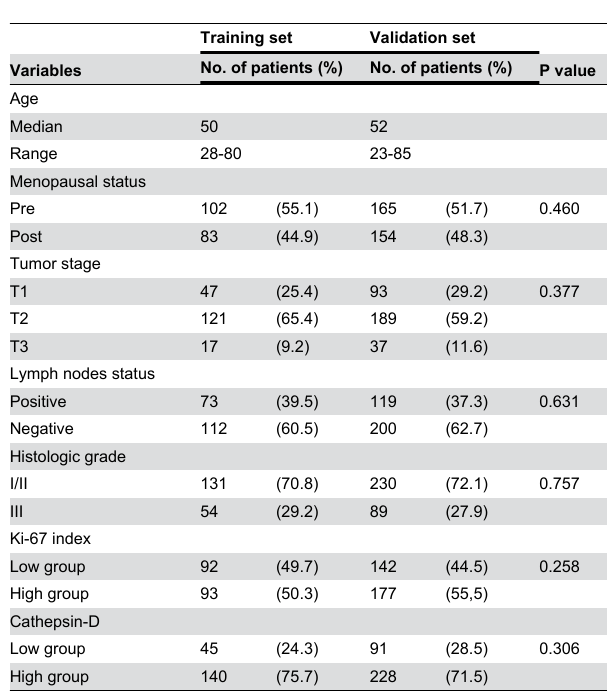
Table 1. Clinicopathological characteristics of patients in the training and validation